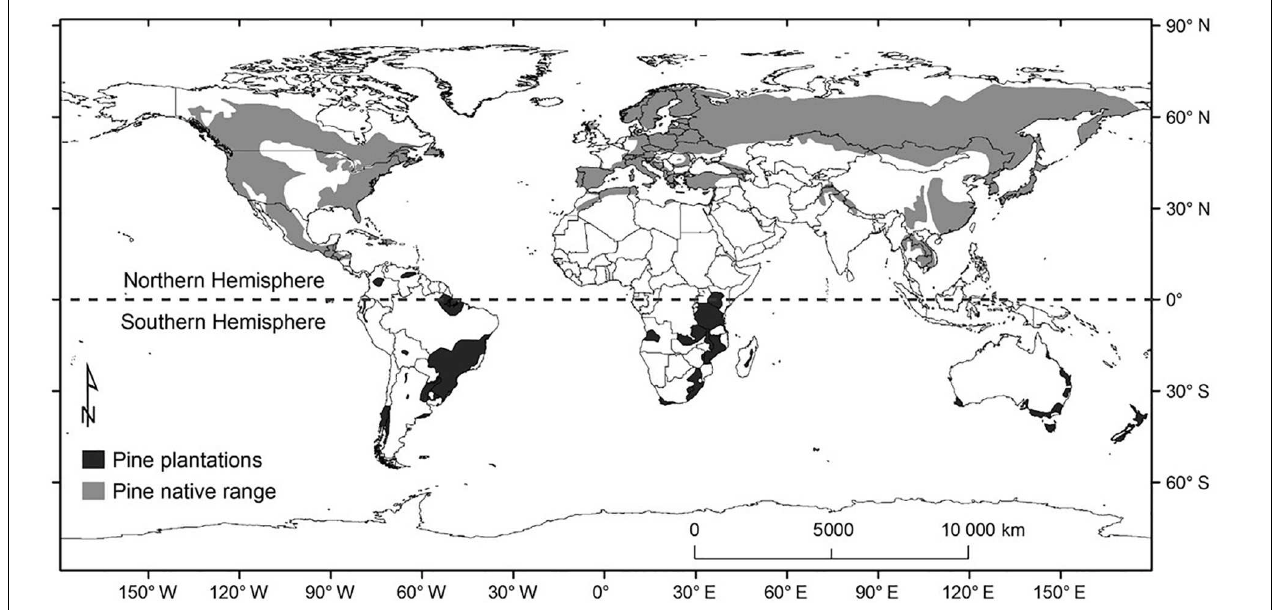
FIGURE 1 | Native range of pines, and distribution of pine plantations in the Southern Hemisphere [map from Lantschner et al. (2017), used with permission from John Wiley and Sons (RightsLink License # 4847761041822)].